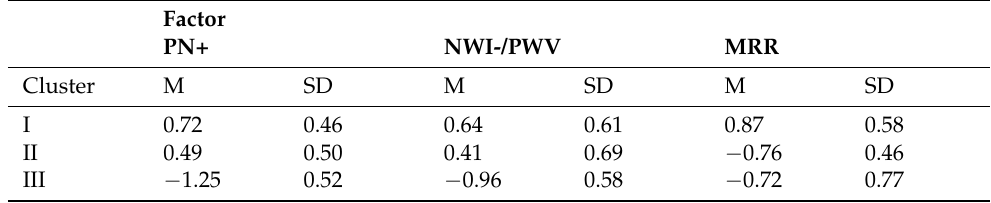
Table 6. Mean factor scores and standard deviation of the three clusters per factor. Factor